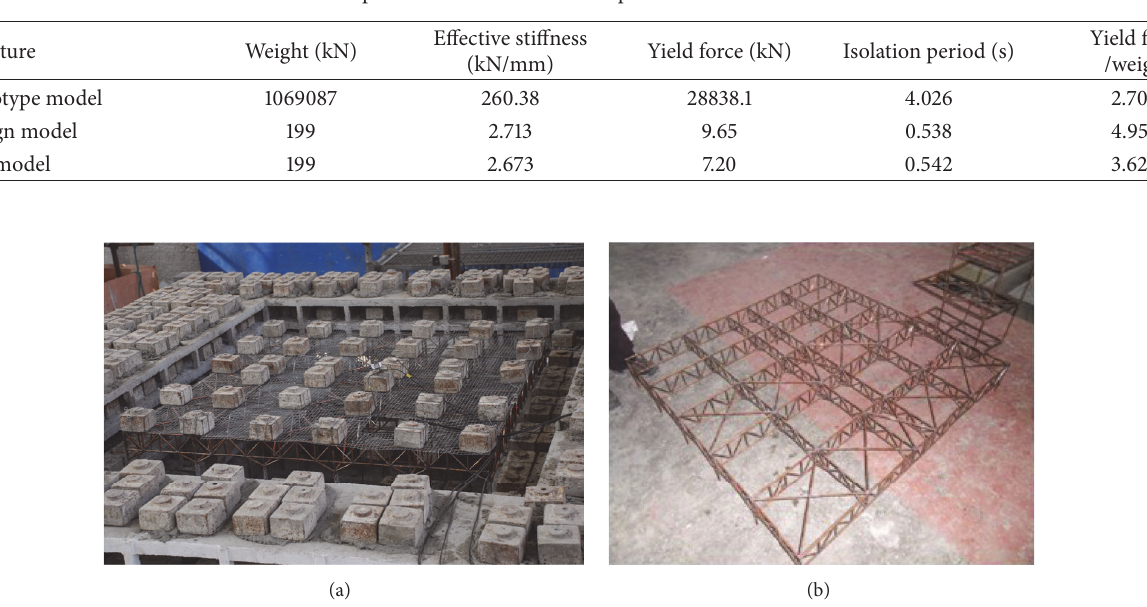
Table 8: Comparison of isolated structure parameters at 100% shear strain.